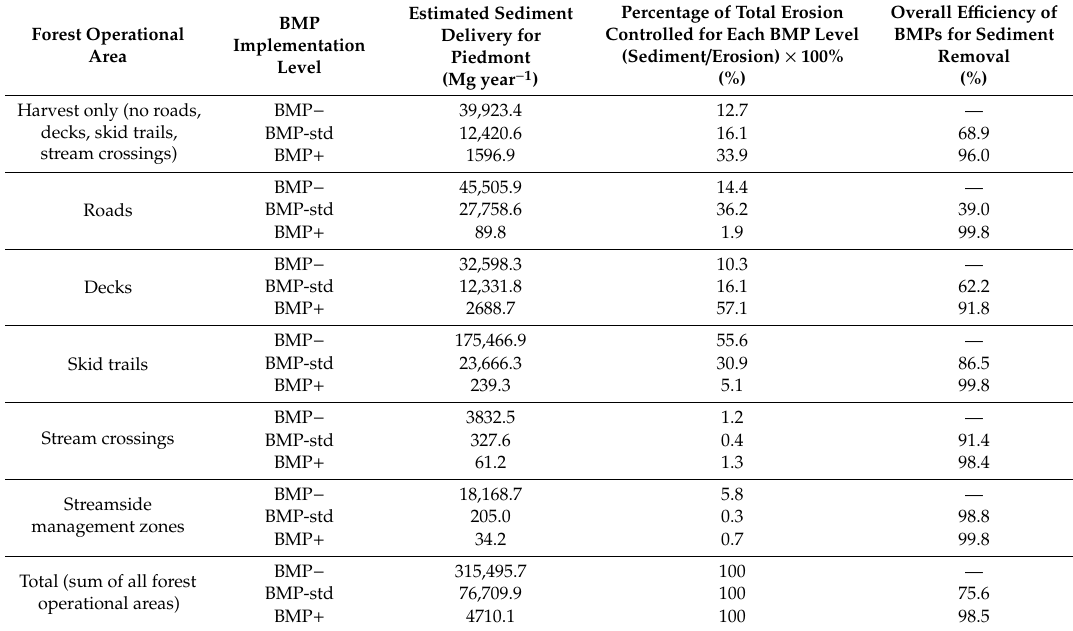
Table 13. Total estimated sediment delivery and overall e ffi ciency by BMP implementation level for all Piedmont harvests in the five-state area (all operational